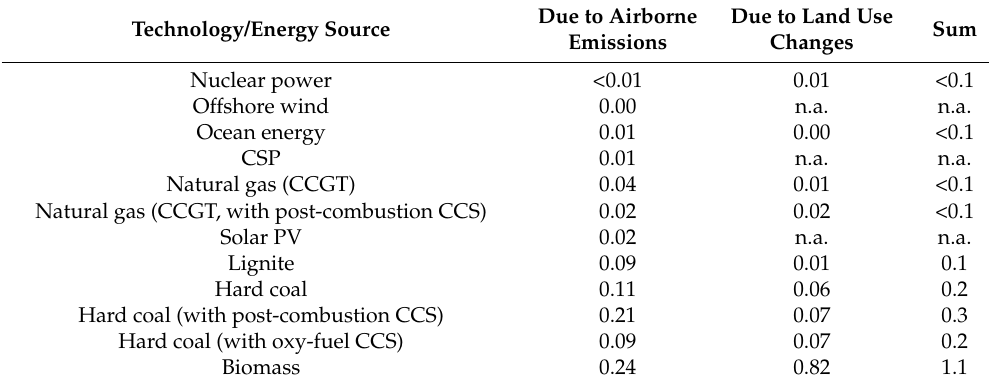
Table 9. Estimates for the costs of biodiversity impacts of state-of-the-art electricity generation technologies around the year 2009 (2025 for CCS technologies) (in € -cent 2015